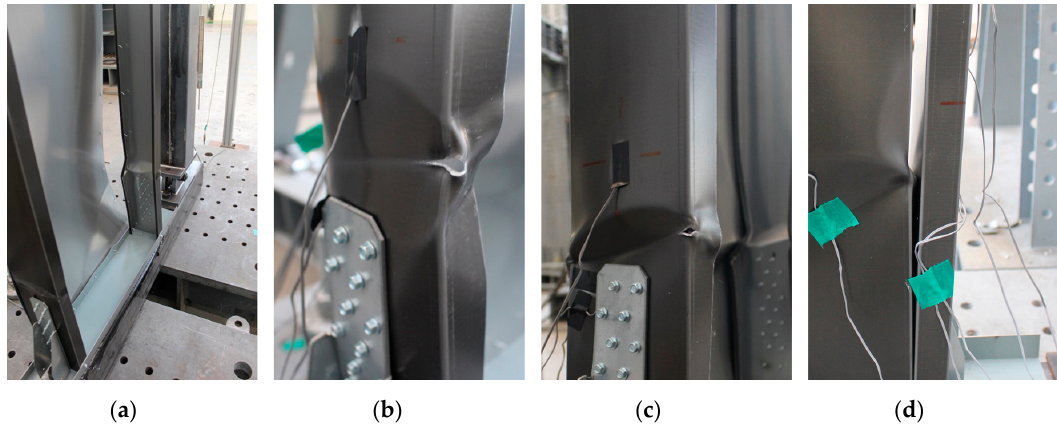
Figure 7. Failure modes of specimens: ( a ) Screw pull-out of the steel-sheathed panel (SSP) specimen, ( b ) Local buckling and tearing of the integrated panel-inner stud (IP) specimen, ( c ) Local buckling and tearing of the integrated panel-inner stud (IP-IS) specimen, ( d ) Local buckling of the integrated panel-outer stud (IP-OS) specimen.